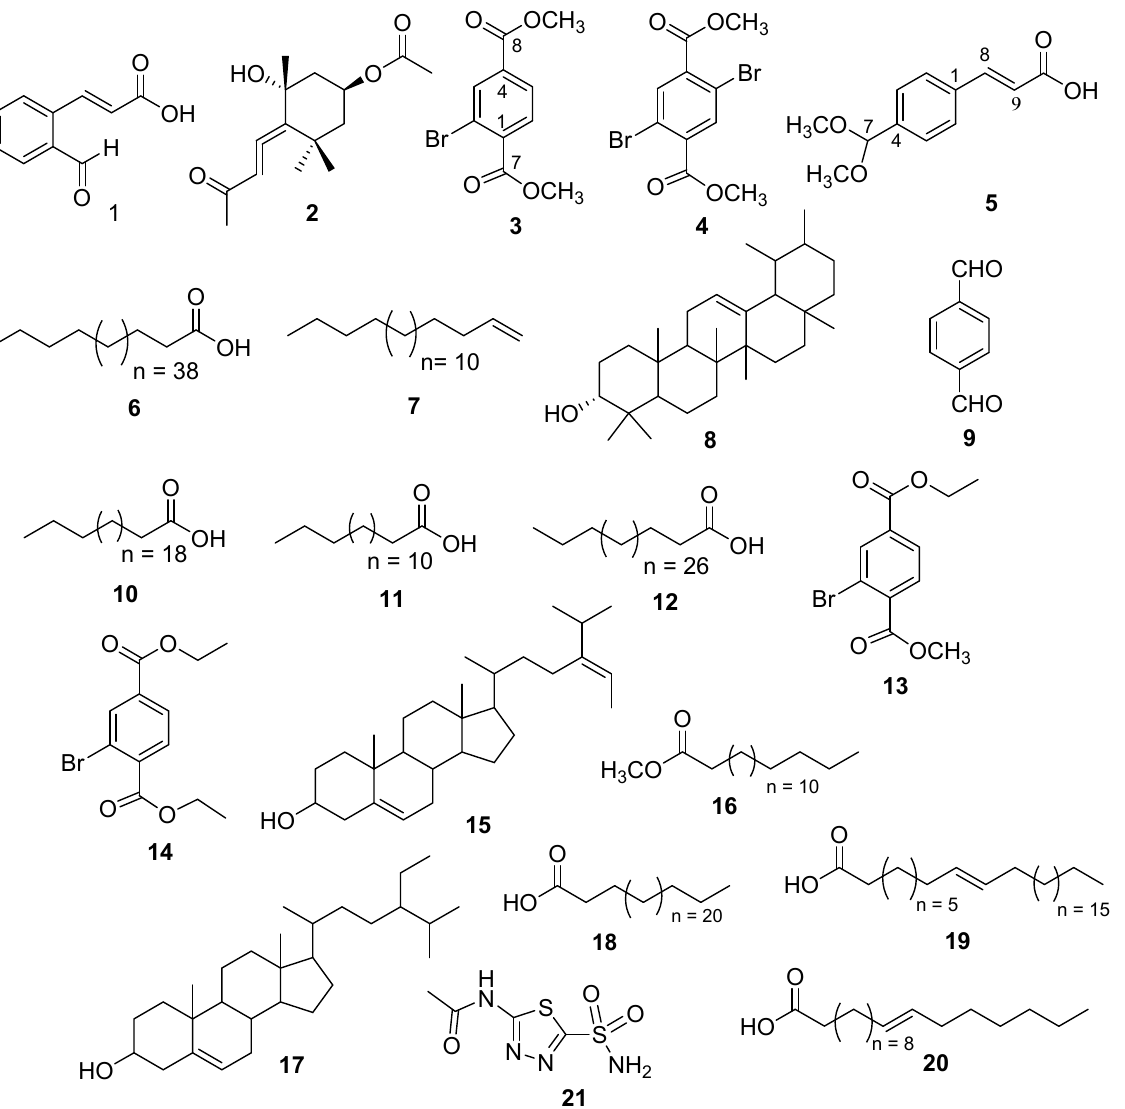
Figure 2. Structures of the compounds 1 – 20 isolated from D. hoytii and acetazolamide ( 21 ). Compound 4 was isolated as a white powder with a molecular formula, C 10 H 8 Br 2 O 4 , established by positive HR-ESI-MS at m / z 367.8938 ([M + H 2 O] + (Calcd. 367.8895) (Figure 2). The 1 H- and 13 C-NMR spectra of 4 closely resembled those of compound 3 with the only difference being additional bromine at C-4 attached to the benzyl ring. Due to symmetry in the molecule, one downfield signal at δ 8.04 with double integration (2H, s, H-3/6) was observed in 1 H-NMR spectra assigned to two aromatic protons H-3/6 and this was further confirmed by 13 C-NMR spectra at δ 166.3 (C-7/8). Moreover, the 1 H-NMR spectrum displayed two signals at 3.96 (3H, s), and 3.88 (3H, s), which corresponded to the presence of two methoxy groups and their HMBC correlations with C-7/8 further confirmed the presence of dimethyl esters (Figure 2). The HMBC correlations of H-3 to C-2, C-4, C-1, and C-8 and H-5 to C-6, C-4, C-8, and C-1 further indicated the presence and position of ester groups at C-1 and C-4 in the molecule. Because of these advance spectroscopic tech- niques and above observations, the structure of compound 4 was designated as dimethyl